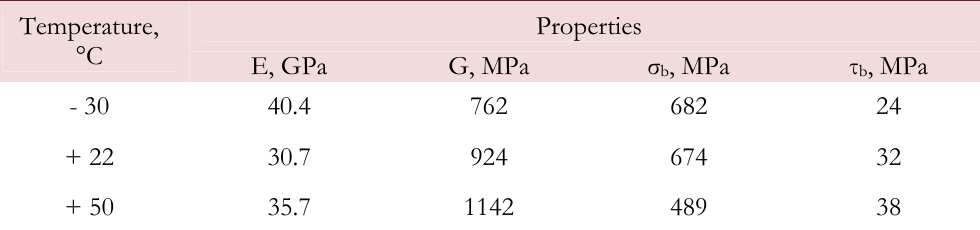
F EATURES OF FAILURE